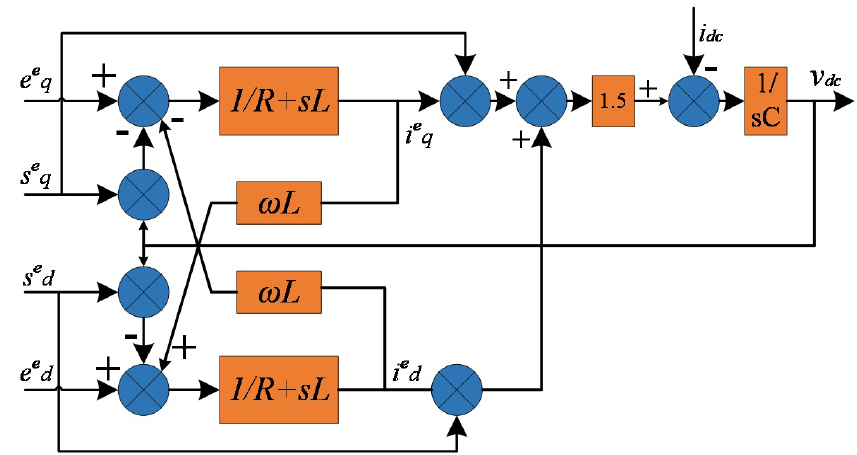
Figure 6. d − q model of the three-phase voltage source rectifier.